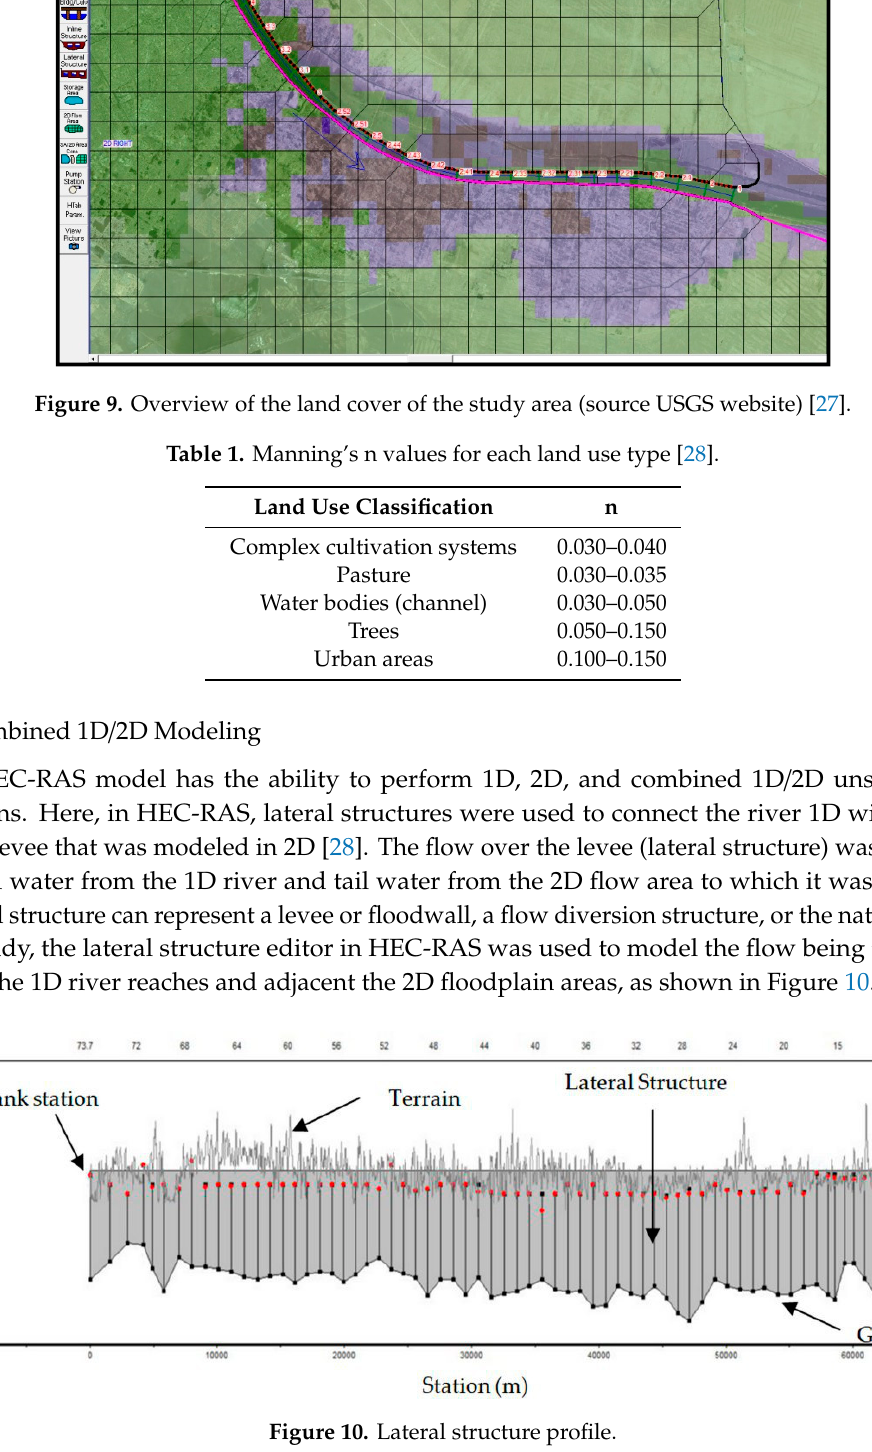
Figure 10. Lateral structure profile.